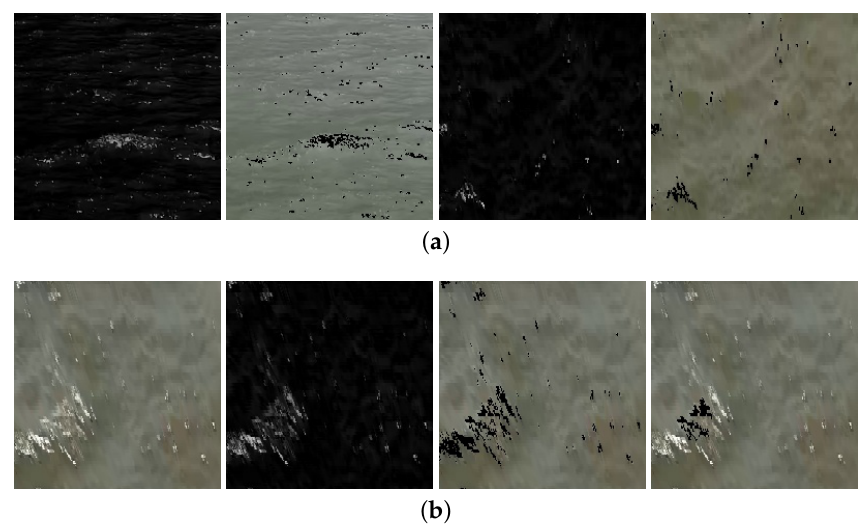
Figure 16. ( a ) The top-hat transform and abnormal detection results of sun glints in Figure 15 and C 3 ; and ( b ) the whitecap separation process, from the original image to top-hat transform result and abnormal detection result and, finally, to the whitecap separation result in C 4 .